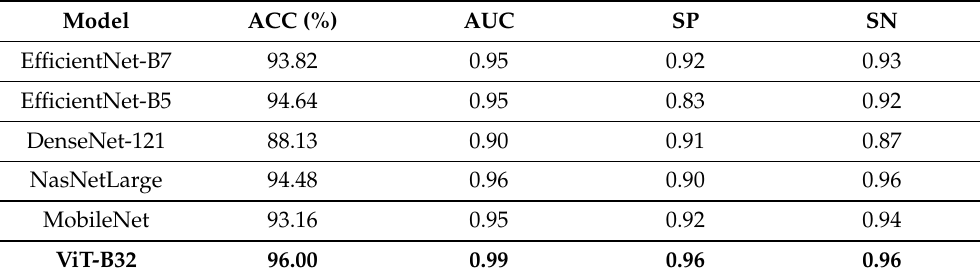
Table 3. ACC, AUC, SN, and SP of our deep Vision Trans- former models for detecting COVID-19, Pneumonia, and Normal Vs. existing SOTA CNN